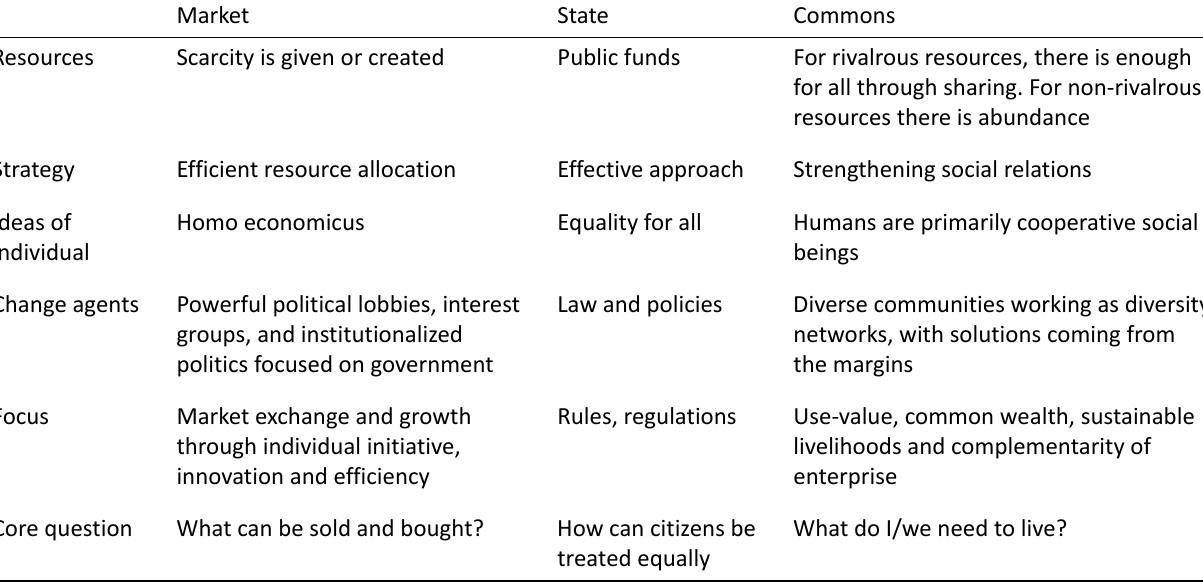
Table 1. A short comparison of the market, the state, and the commons.